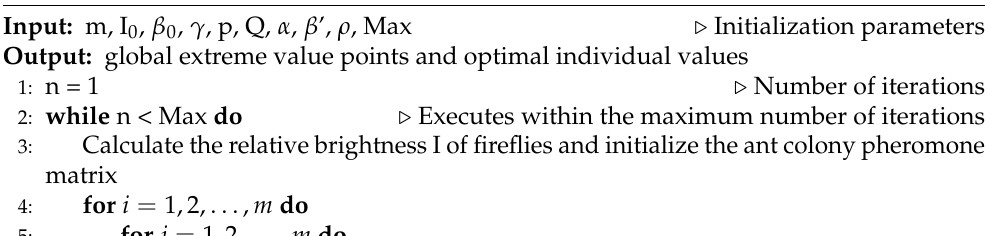
Algorithm 1 FaCO